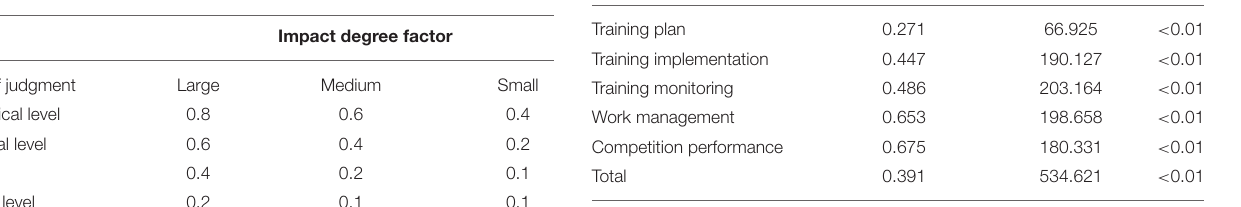
TABLE 3 | Judgment basis of expert questionnaire indicators.